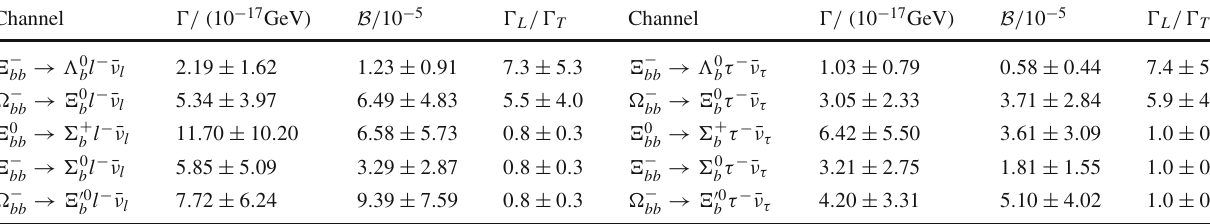
Table 16 Same as Table 15, but for the bb sector Channel